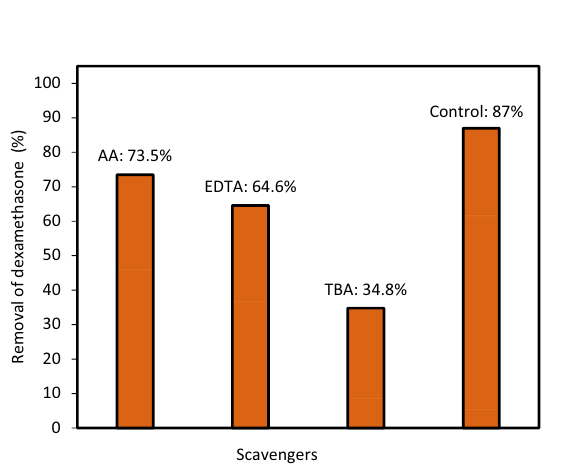
Figure 8. Impact of MgO dose on the rate of DEX removal: initial dexamethasone content = 20 mg/L, pH = 3, and hydrogen peroxide dosage = 5 mM.